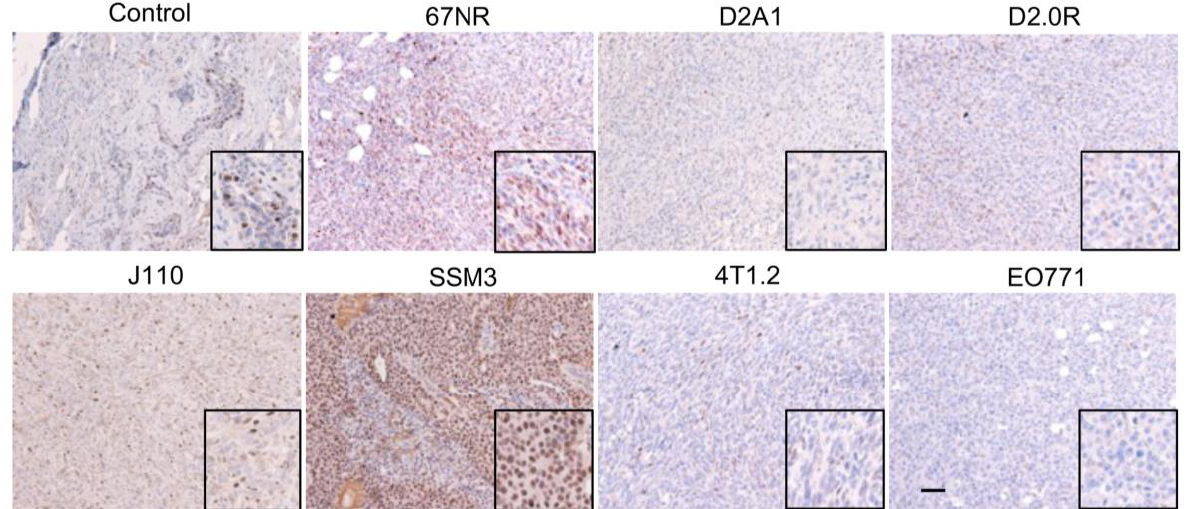
Figure 1. Er α expression in a collection of mouse mammary tumours. Immunohistochemical staining of Er α in epithelial tumour cells of various syngeneic mouse models. The only two cell lines producing tumours with nuclear Er α expression are the 67NR and SSM3 cells. Control: normal mouse mammary gland. Scale bar = 50 µm.